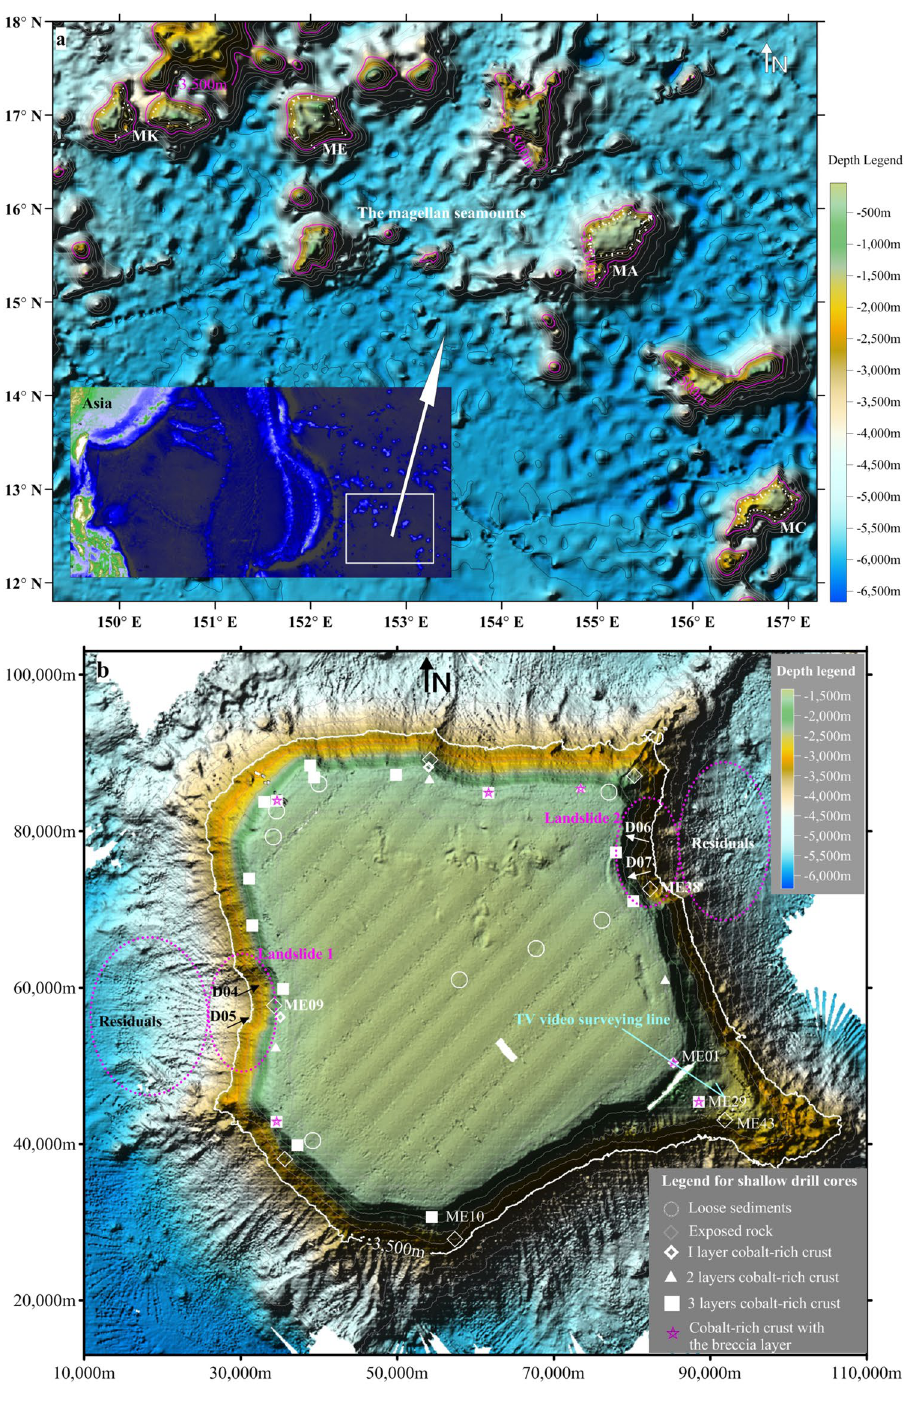
Figure 1. The Magellan Seamounts and locations of geological survey sites on them. ( a ) The map images are created using the SRTM30_PLUS 13 . Surveys acquired 205 shallow boreholes, including 82 from seamount MA, 51 from seamount MC, 37 from seamount ME and 35 from seamount MK, together with 20 TV grabs and 161 dredging samples on slopes between 1200 and 3500 m deep. Shallow drill sites are indicated by white dots shown in ( a ). Bathymetric data on the four seamounts covering an area of approximately 40,000 km 2 measured using the EM122 Multibeam Survey System (Kongsberg, Inc.) by several survey cruises of the COMRA. Topography image of the seamount ME created using the bathymetric data is shown in ( b ). The TV video surveying line covering 18 km and two sizeable landslides on the flank of seamount ME are shown in ( b ), will be involved in the